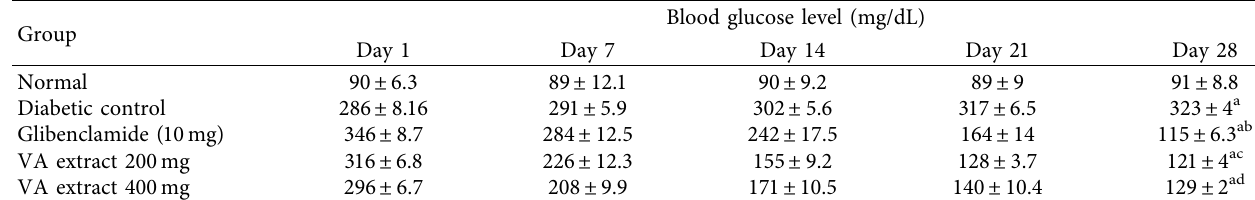
Table 1: Hypoglycemic effect of V . album